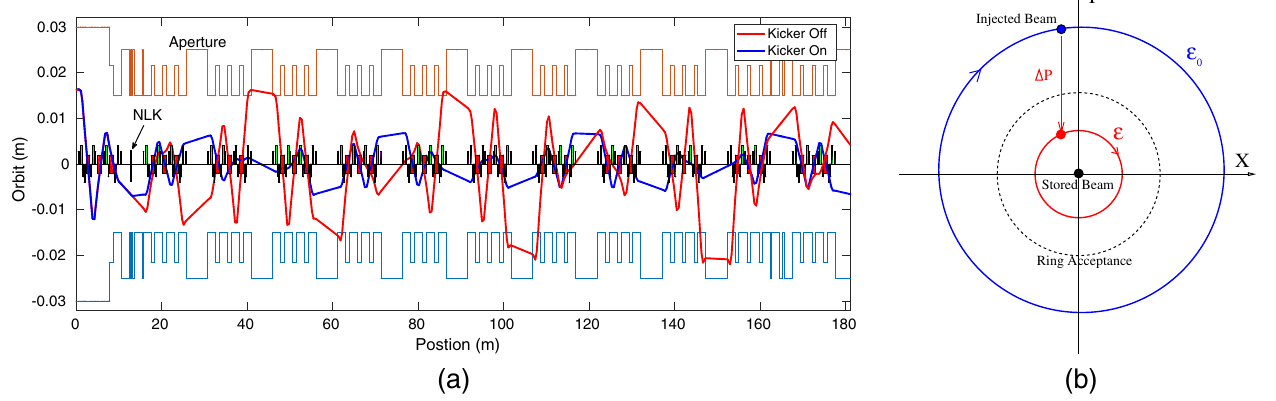
FIG. 2. Illustration of a nonlinear kicker injection into the ALS-U accumulator ring. (a) A single particle tracking for the first turn with the NLK kicker turned ON and OFF. (b) Diagram of the NLK injection in a normalized phase space. The large blue, median dash, and small red circles represent the injection invariant, ring acceptance and reduced invariant of the injected beam,